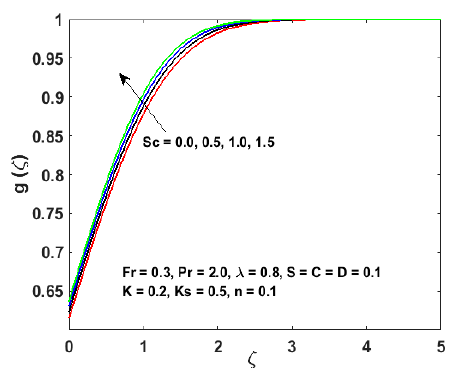
( ) g ζ . Figure 11. E ff ect of the Schmidt number ( Sc ) on g ( ζ ) .